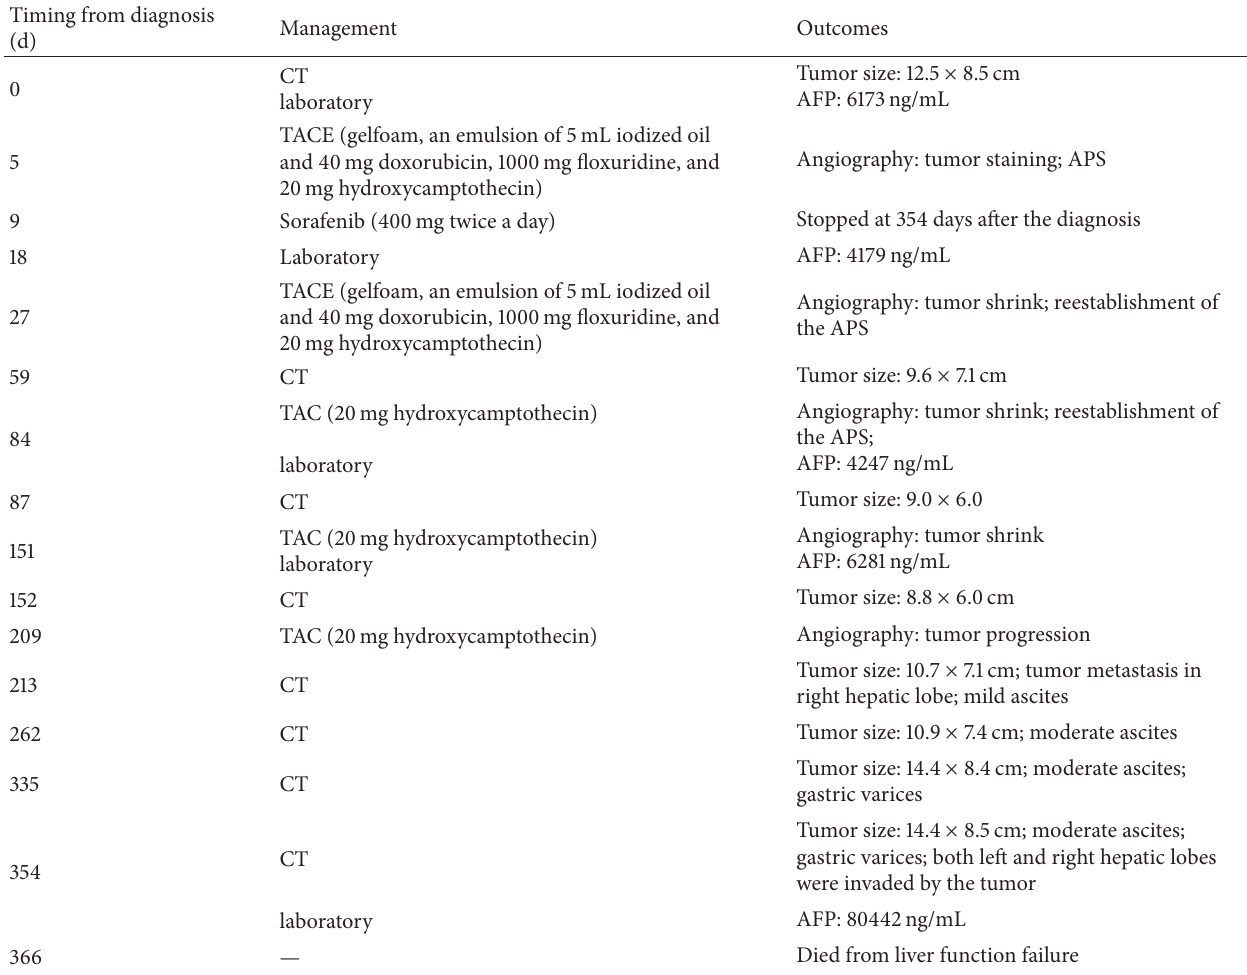
Table 1: Managements and